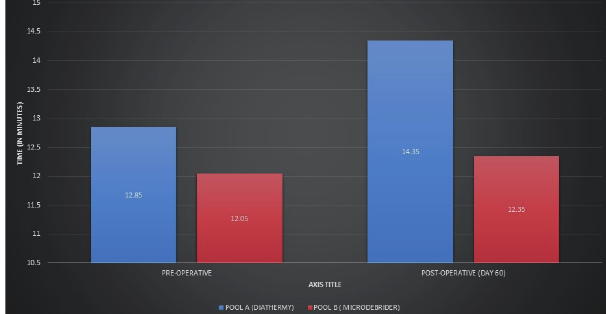
Figure 4. Mean nasal mucociliary transit time (in